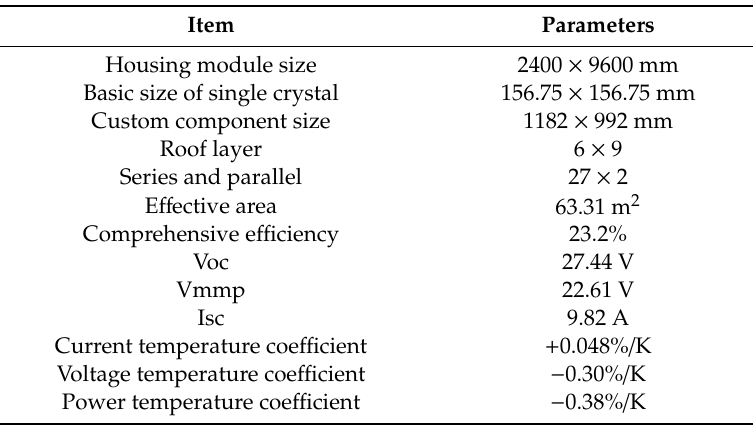
Figure 8. Rooftop solar photovoltaic and solar thermal panels. Table 1. i-Yard 2.0 Photovoltaic System Parameters Table.